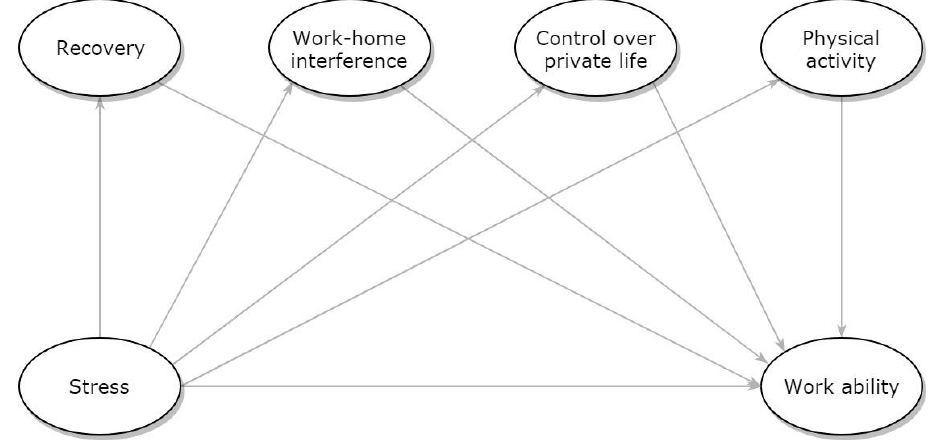
Figure A1 : Primary theoretical framework consisting of four dimensions of possible mediating factors of the relationship between stress and work ability.